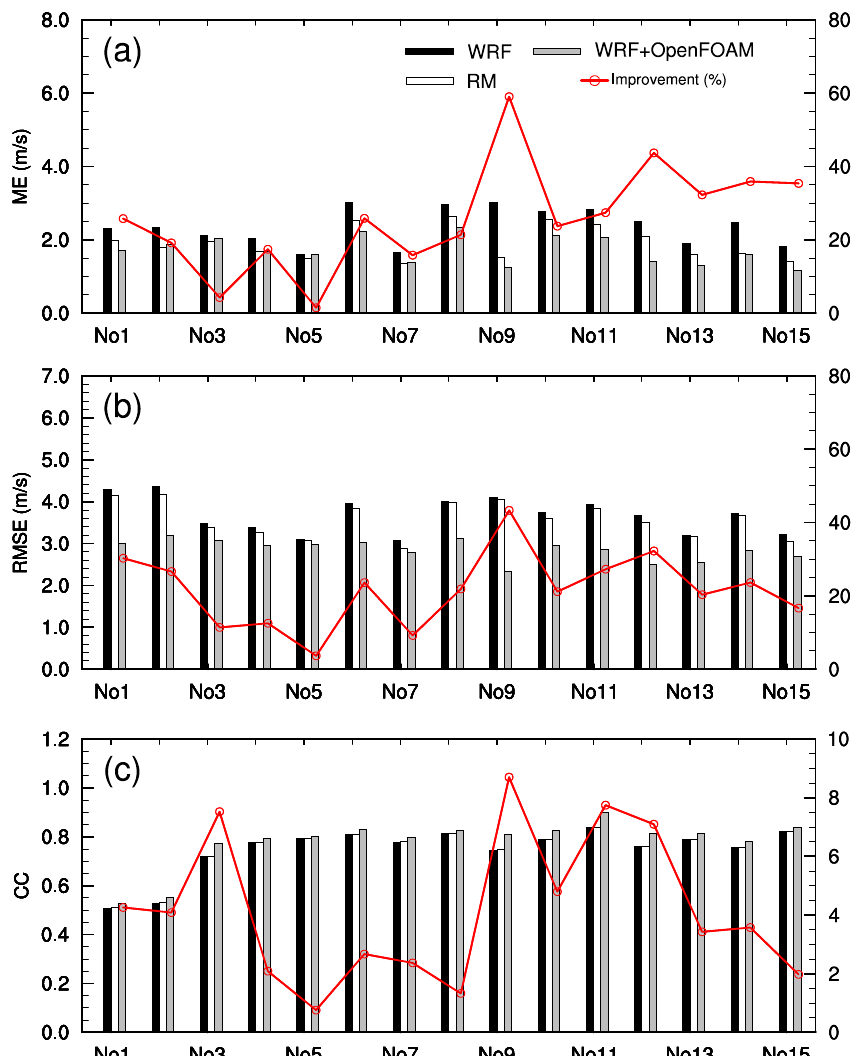
Figure 5. A comparison of mean error (ME) ( a ), root mean square error (RMSE) ( b ) and correlation coefficient (CC) ( c ) of the WRF model (solid black bar), the running mean method (solid white bar) and the coupled model (solid gray bar) forecasts of wind speed for the 15 turbines of the Awaji-island wind farm in Japan. The red line stands for the relative improvement by WRF/OpenFOAM coupled model in comparison with the WRF-alone forecasts and the forecasts using running mean